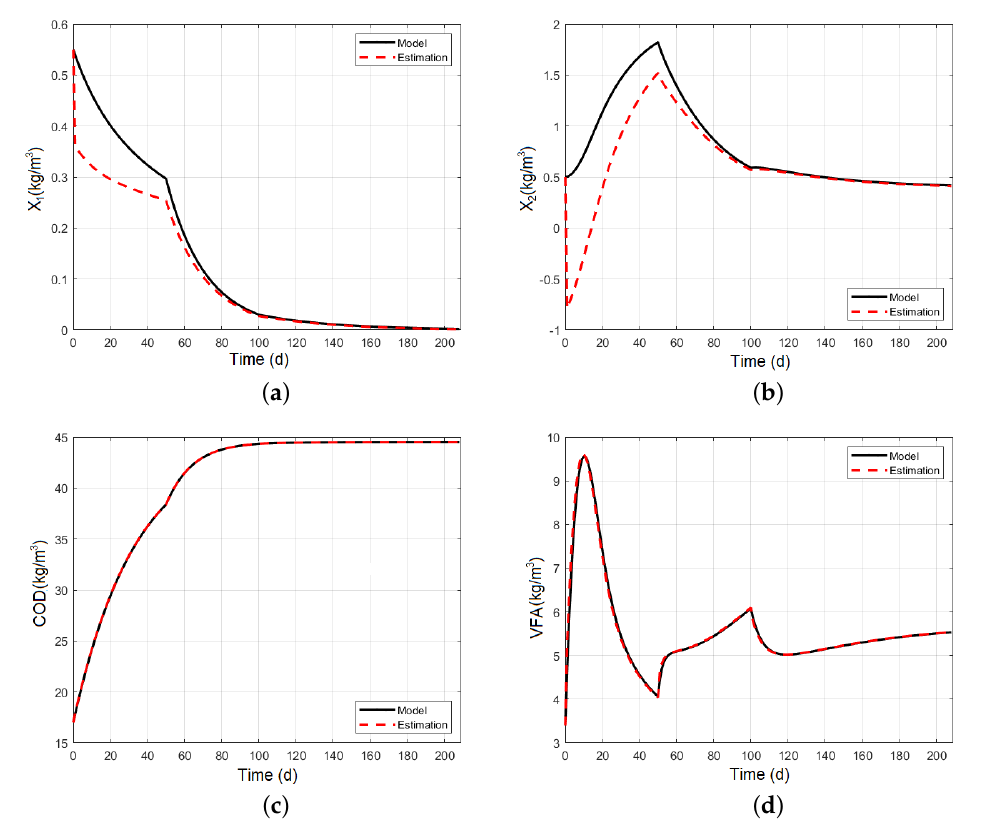
Figure 4. Kinetic reaction estimator to state variables considered. ( a ) Acidogens concentration X 1 ; ( b ) methenogens concentration X 2 ; ( c ) chemical oxygen demand; ( d ) volatile fatty